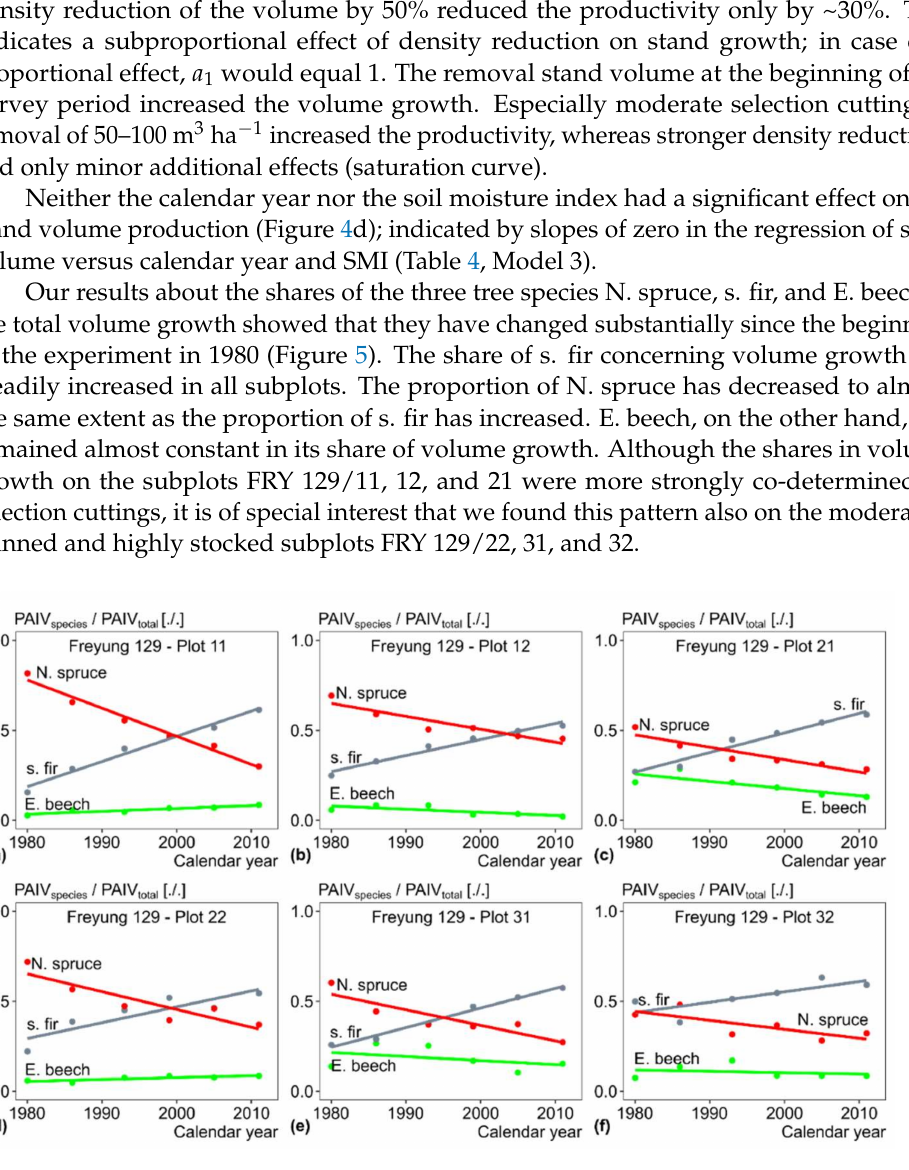
Figure 5. Trends in the shares of the periodic annual volume increment ( PAIV species / PAIV total ) for the three tree species Norway spruce (red), silver fir (grey), and European beech (green) on the selection forestry experiment Freyung 129. Lines were generated by fitting a simple linear model. The trends are shown on the six subplots FRY 129/11 ( a ), 12 ( b ), 21 ( c ), 22 ( d ), 31 ( e ), and 32 ( f